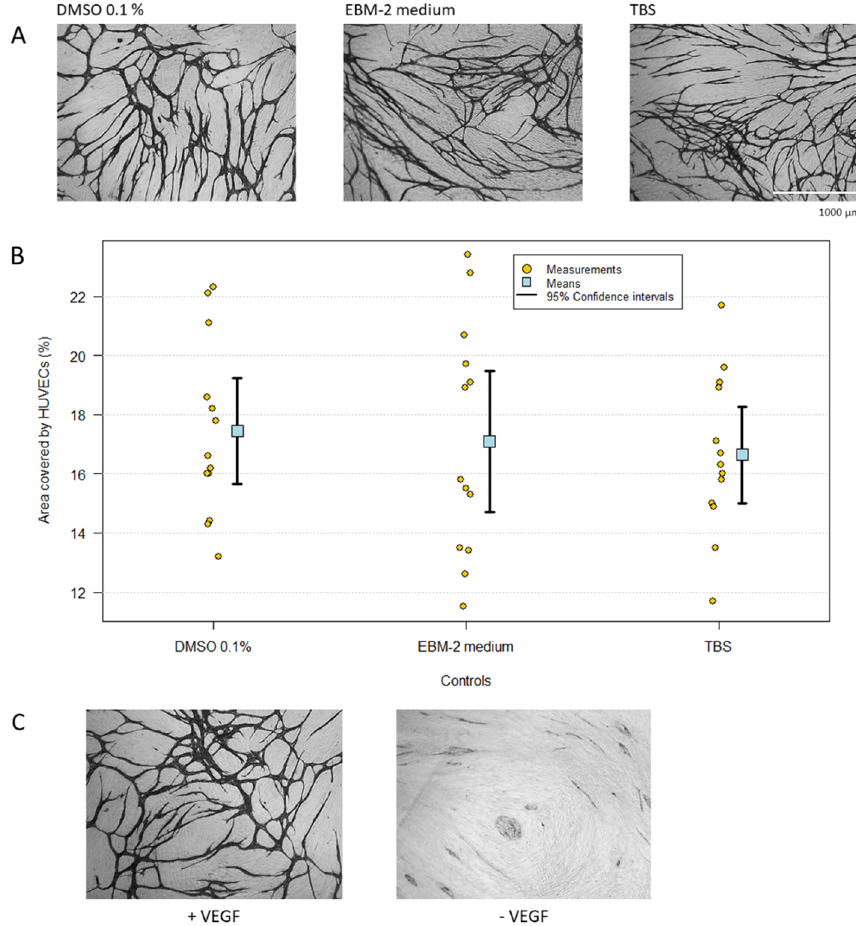
Figure 1. ( A , B ) Comparison of control groups. One-way ANOVA, F = 0.20 and P = 0.82. ( C ) The effect of VEGF on HUVEC differentiation. The HUVECs were cultivated in TFSM2-medium supplemented with and without VEGF. In presence of VEGF, the HUVECs form a capillary-like network. In the absence of VEGF, HUVECs form clusters and cords (magnification: 4×).